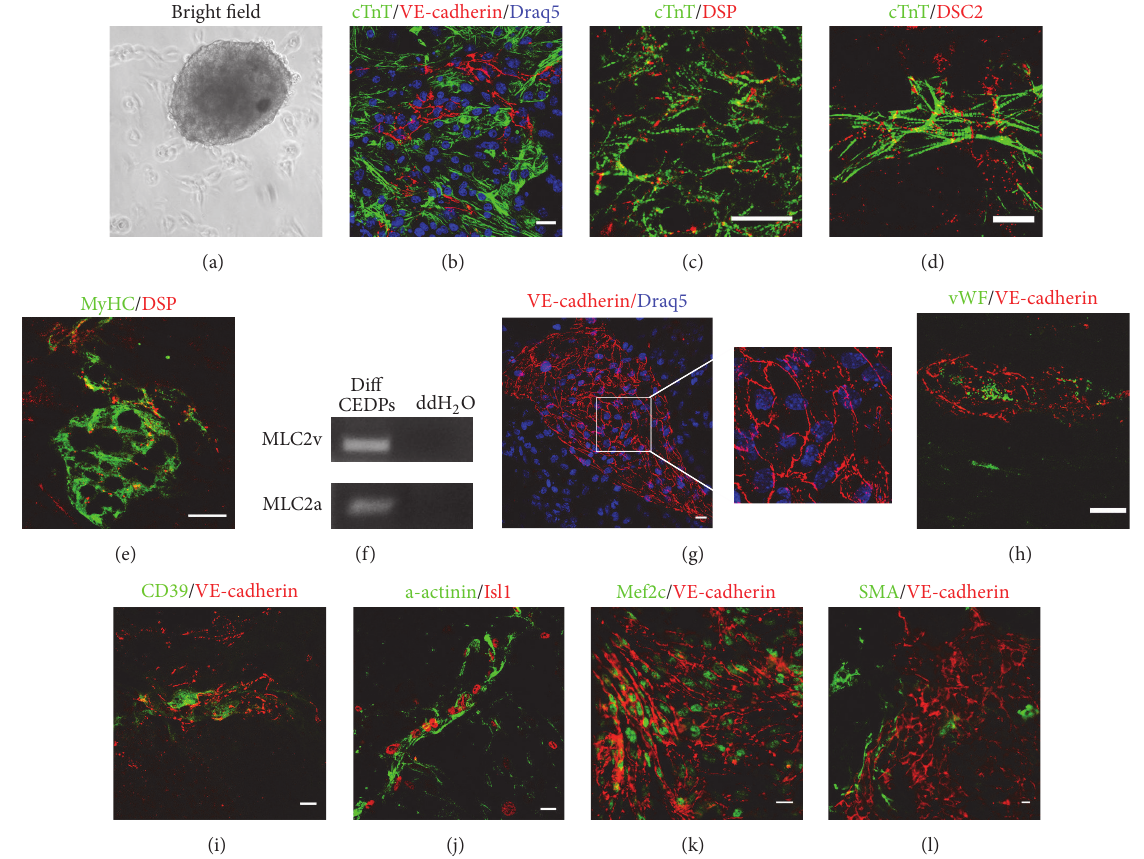
Figure 5: CEDPs differentiation potential. (a) Optical microscope image of a sphere formed in the absence of SB-216763 after 5 days of CEDPs differentiation. (b) cTnT + cells formation after immunostaining with anti-cTnT and anti-VE-cadherin. (c–e) Formation of intercalated disk structures in beating spheres after 10 days of CEDPs differentiation, shown by double-IF-staining with anti-cTnT/anti-Desmoplakin (DSP), anti-cTnT/anti-Desmocollin-2 (DSG2), and anti-MyHC/anti-Desmoplakin. Note the striations of the sarcomeric cTnT staining and the punctate desmosomal staining in areas connecting adjacent cardiomyocytes. (f) Expression of MLC2v and MLC2a after 10 days of CEDPs differentiationbyRT-PCRanalysis.(g)VE-cadherin + cellsinCEDPs-deriveddifferentiatedcells.Noteextensiveadherensjunctionsformation between endothelial cells. Magnification corresponds to marked area. (h-i) Expression of vWF and CD39 in VE-cadherin + endothelial cells after10daysofCEDPsdifferentiation.(j-k)ExpressionofIsl1andMef2cprogenitormarkersina-actinin + andVE-cadherin + cells,respectively, at day 10 of CEDPs differentiation. (l) Expression of SMA during CEDPs differentiation. Draq5 counterstained DNA (b, g). Scale bar: 20 𝜇